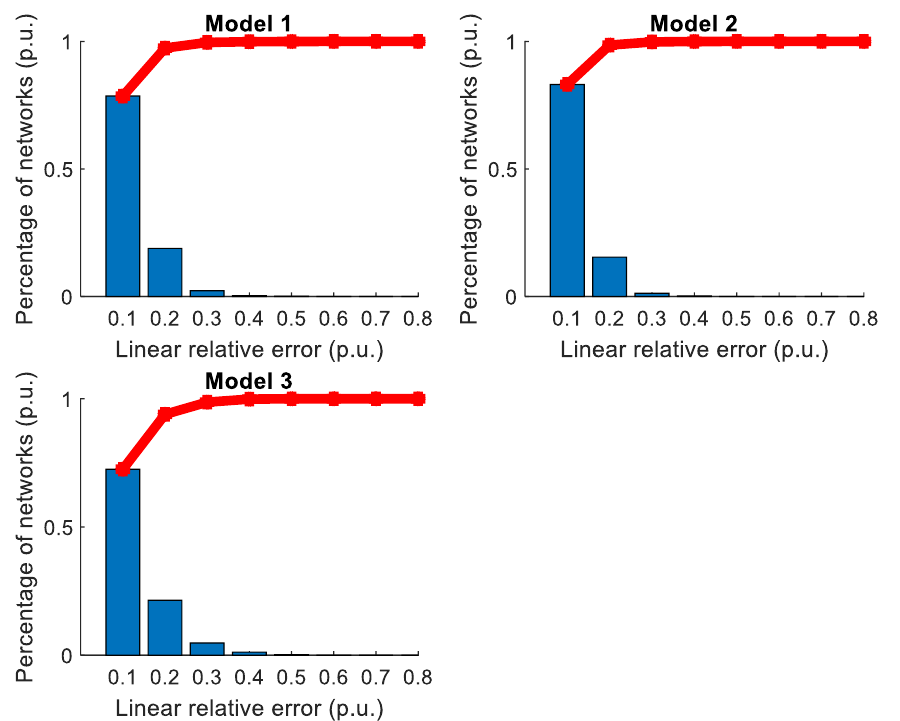
Figure 9. Linear relative error (p.u.) for each model.